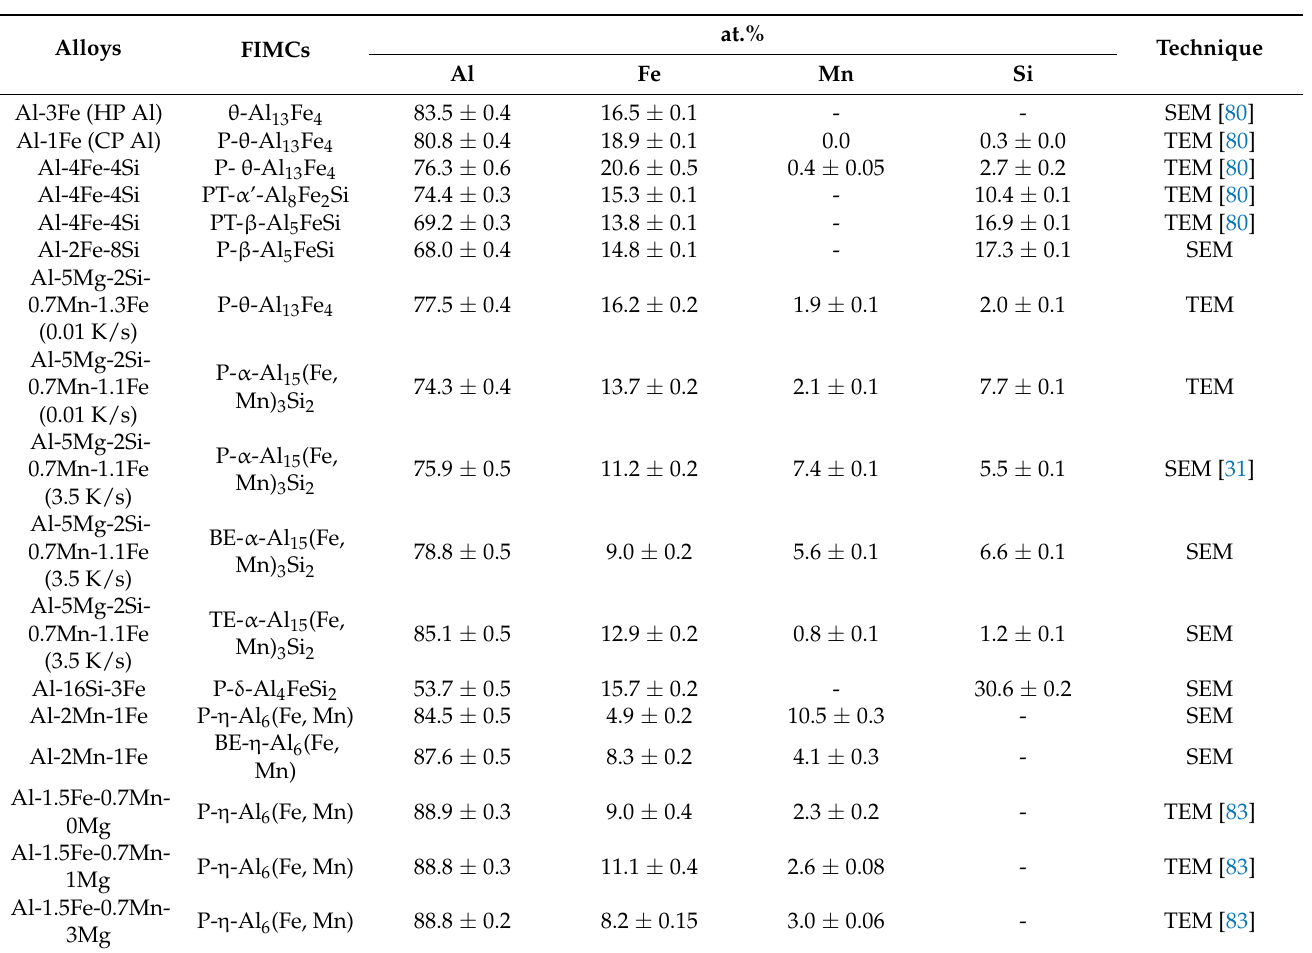
Table 3. The composition of different types of FIMCs.